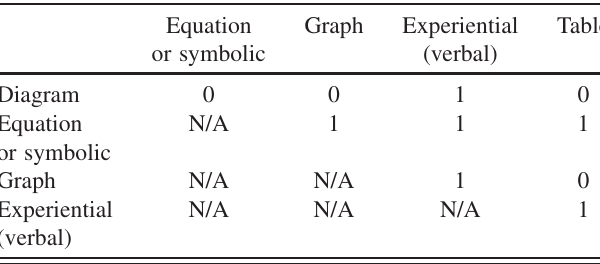
TABLE II. Connections Amber made between representations. A ‘‘1’’ indicates that Amber made this connection once during her presentation. ‘‘N/A’’ indicates that this cell is not applicable, either because the cell would indicate an invalid connection between a representation and itself, or because this same con- nection appears in another cell in this table, and the information is given in the other